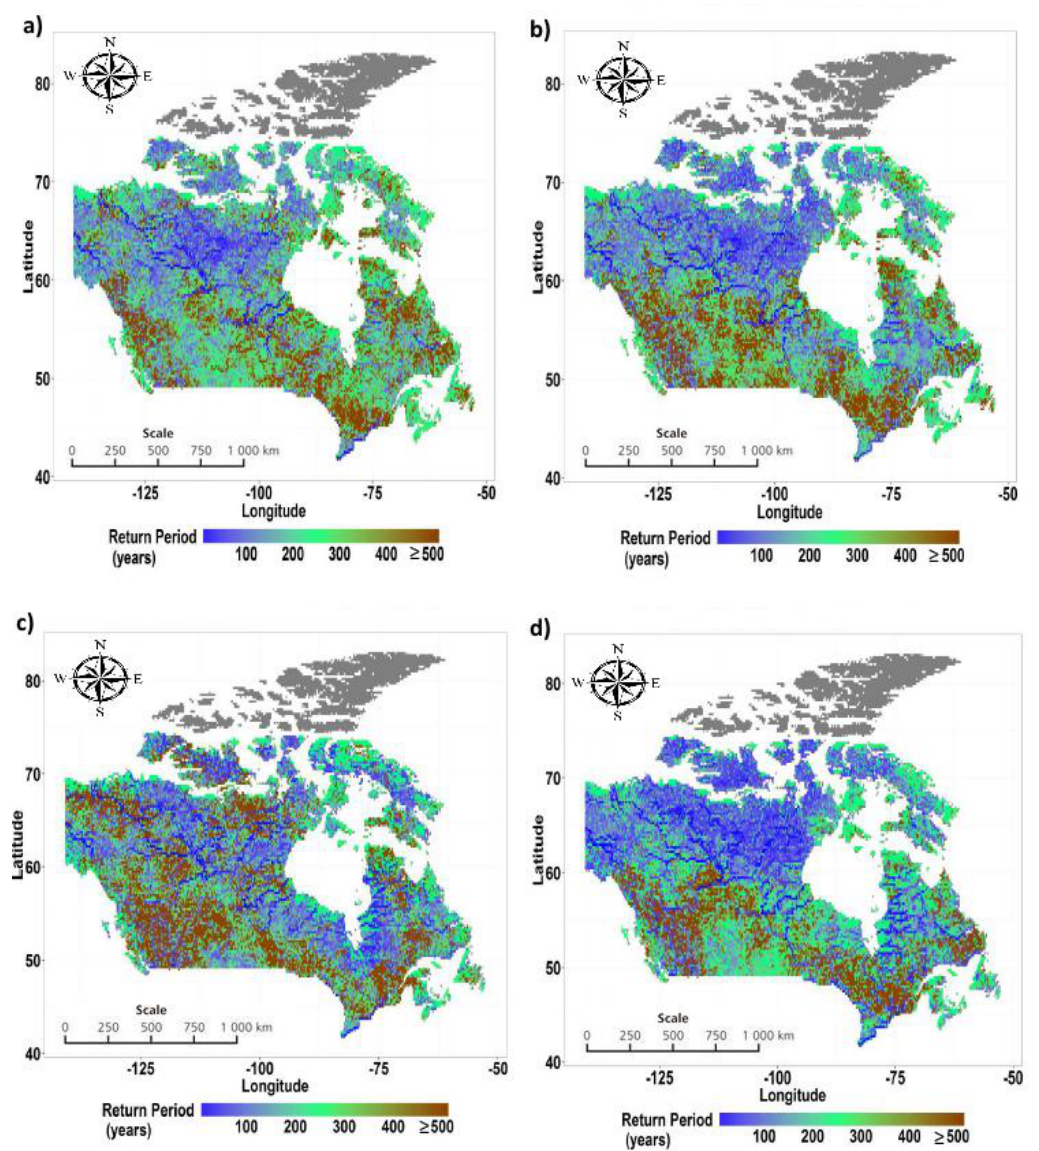
Figure 4. Future return periods of a historical 250-year flood event for: ( a ) RCP 2.6; ( b ) RCP 4.5; ( c ) RCP 6.0; and ( d ) RCP 8.5. The results presented are GCM projections aggregated using the robust GCM median approach.